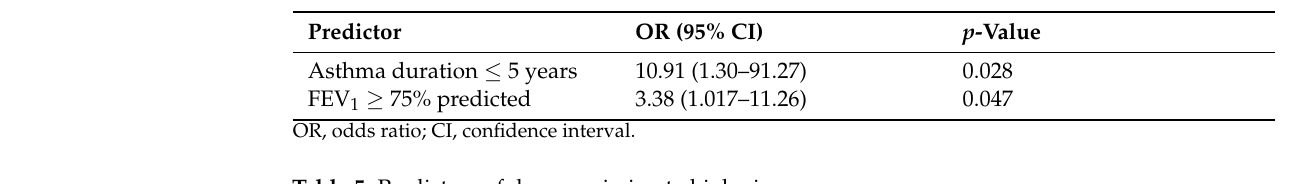
Table 5. Predictors of deep remission to